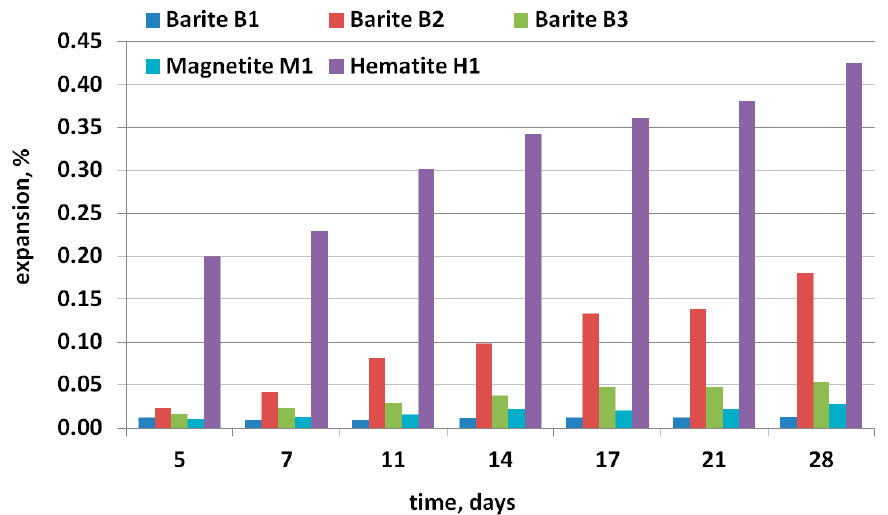
Figure 4. Expansion of mortar bars exposed to 1 M solution of sodium hydroxide and temperature of 80 °C.